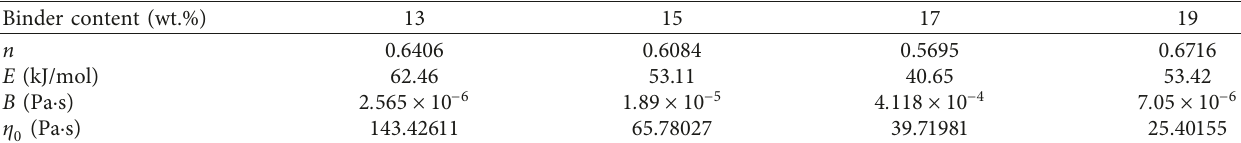
0 values in feedstocks with different binder contents.